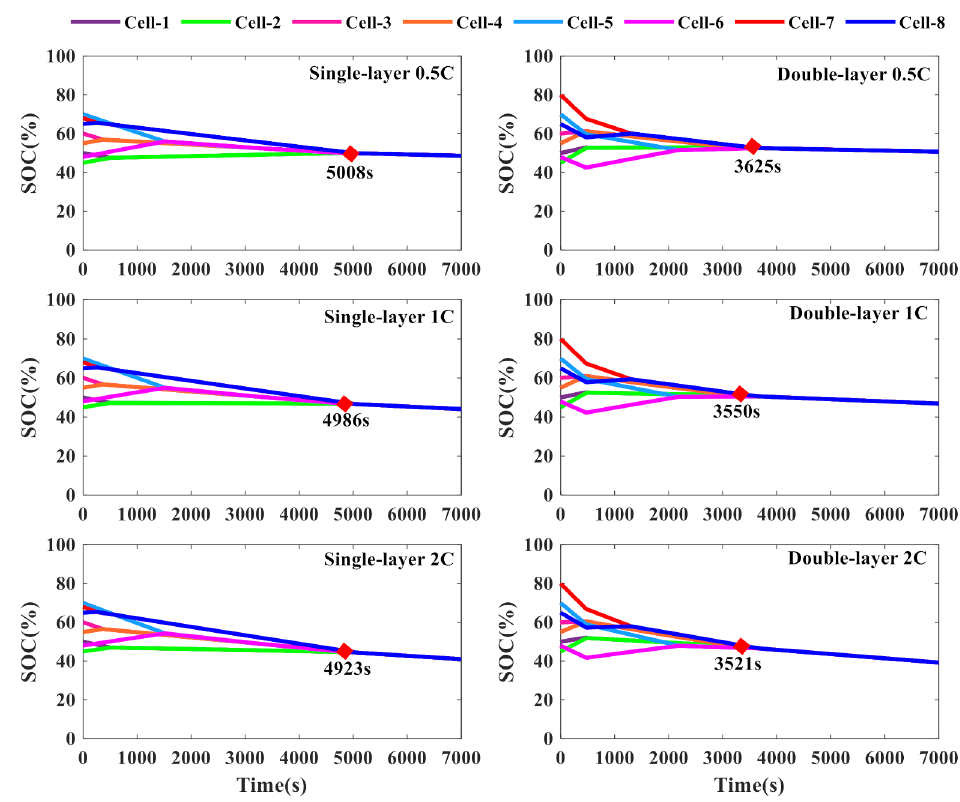
Figure 13. Different discharging rate state simulation